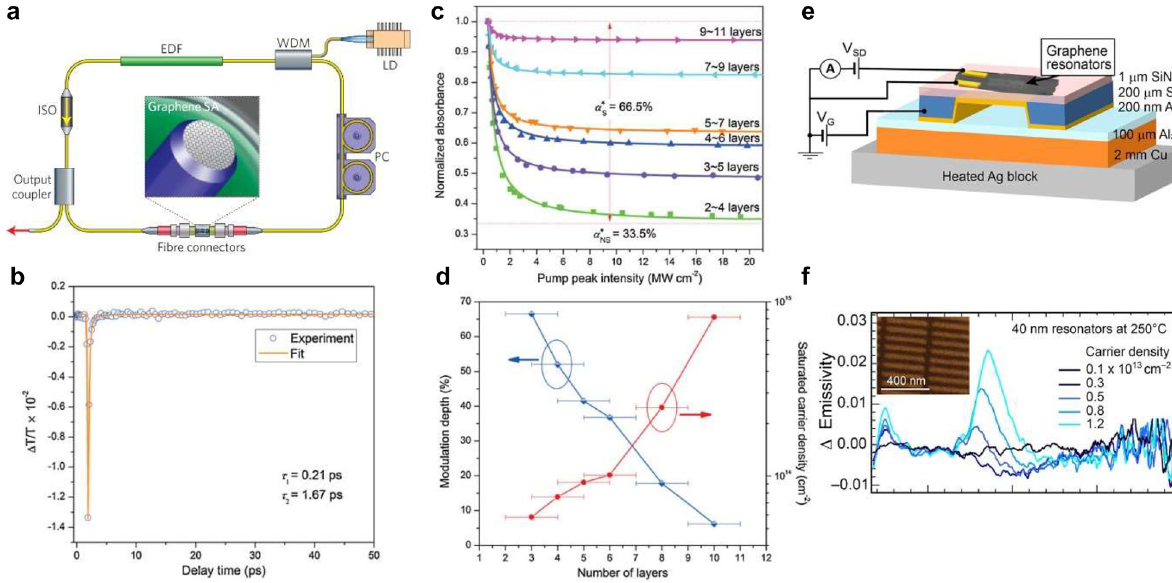
Figure 10: Light-modulation applications of graphene. (a)Graphenemode-lockedultrafastlaser:agrapheneSAisinsertedbetweentwofiberconnectors.Anerbium-dopedfiber(EDF)isthegainmedium, pumpedbyalaserdiode(LD)withawavelength-divisionmultiplexer(WDM).Anisolator(ISO)maintainsunidirectionaloperation,andapolarization controller (PC) optimizes mode-locking. (b) Measured transmissivitytransients for multilayer graphene. Theopen circles aretheexperimental data and the solid curve is analytical fi t to the data using exponentials with time constants t 1 and t 2 . The fast relaxation time t 1 corresponds to carrier – carrierintrabandscatteringratesandtheslowrelaxationtime t 2 correlateswithelectron – holeinterbandrecombination.(c)Nonlinearabsorptionof graphene fi lms vs excitation intensity for different numbers of graphene layers. The dots are the experimental data and the solid curves are analytical fi ts to the data using Eq. (4). (d) Modulation depth and saturated carrier density versus number of graphene layers. (e) Graphene resonators array placed on the temperature-controlled stage with electrostatic gating for emissivity measurements. (f) Carrier density dependence ofchangeinemissivitywithrespecttothechargeneutralpoint(CNP)for40nmgraphenenanoresonators(inset)at250 ° C.Panel(a)isadaptedwith permission from [7]; Panel (b) – (d) are adapted with permission from [156]. Panel (e) and (f) are adapted with permission from